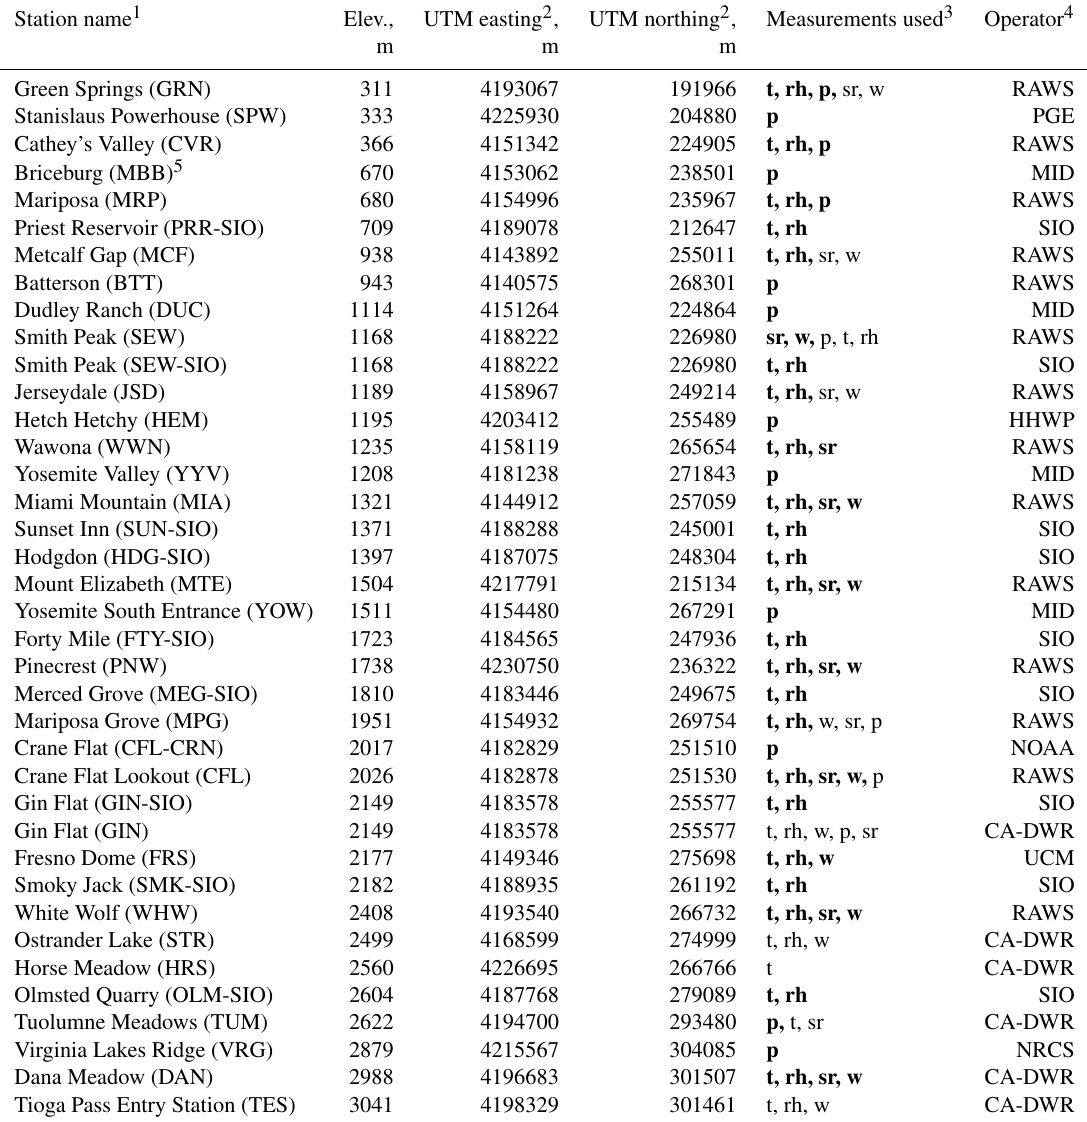
Table 2. Meteorological stations and data used to force